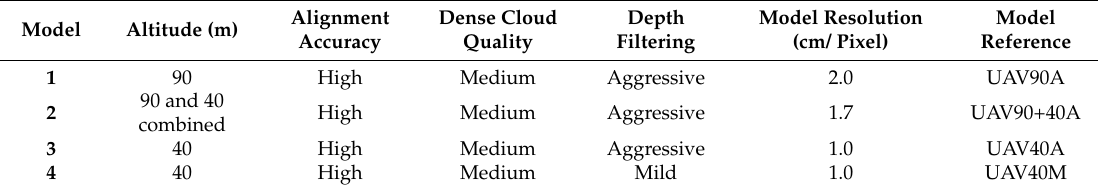
Figure 3. Workflow for processing the collected UAV imagery and Terrestrial LiDAR point clouds into the normalised Digital Surface Model. Table 4. Parameters of the UAV flights and Agisoft Photoscan processing used in the 2014 Pilot Study. Model resolution is the reported model resolution provide by Agisoft